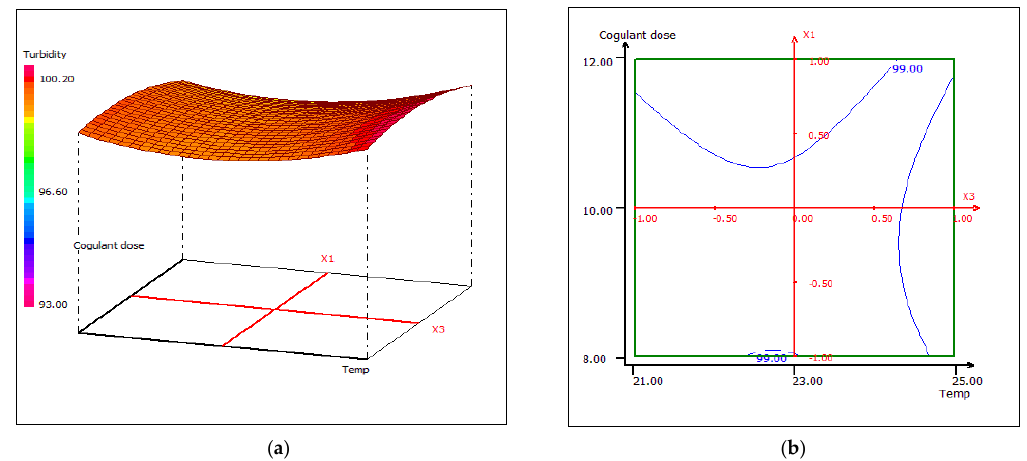
Figure 19. Three-dimensional ( a ) and two-dimensional ( b ) response surface plots for the turbidity of the treated food wastewater using β-chitin extract as a function of coagulant dose and temperature when the pH was maintained at 11.